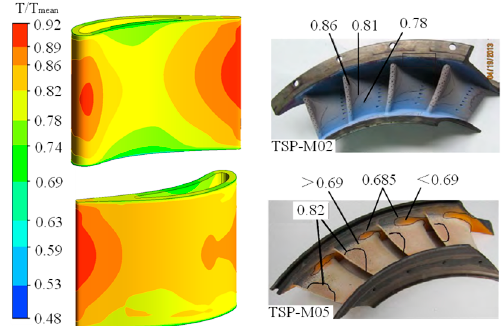
Figure 14. Comparison of the predicted temperature contour with the TSP test.